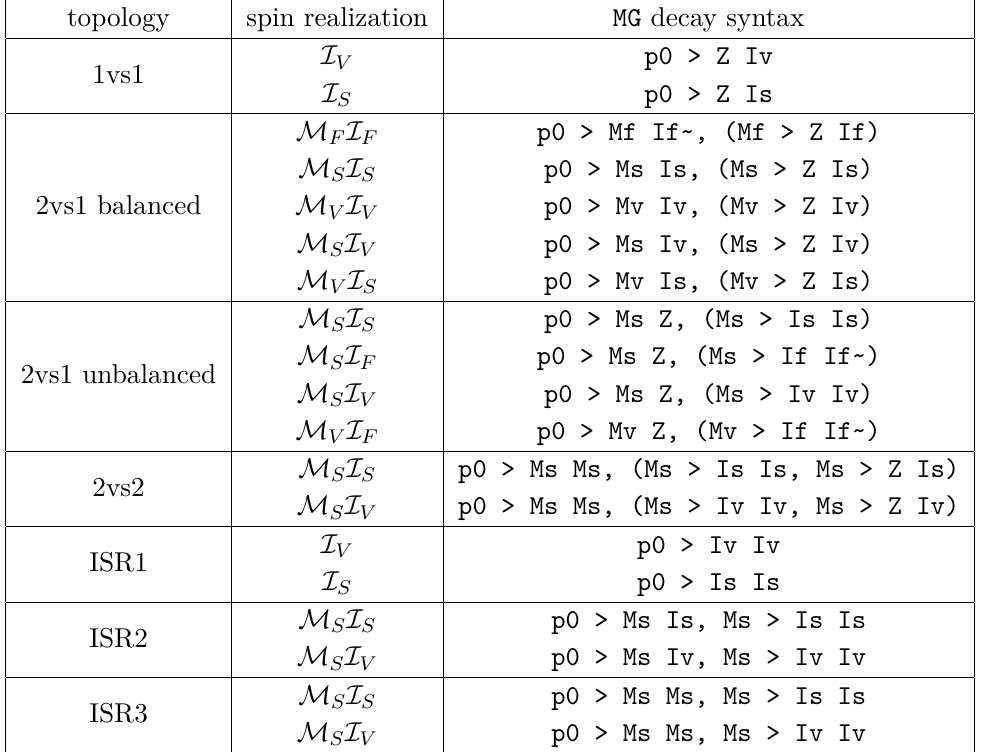
Table 1. List of mono- Z topologies with MadGraph syntax for event generation. The “ISR1” topology corresponds to the left topology of figure 2; the “ISR2” topology to the middle topology of figure 2; and the “ISR3” topology to the right topology of figure